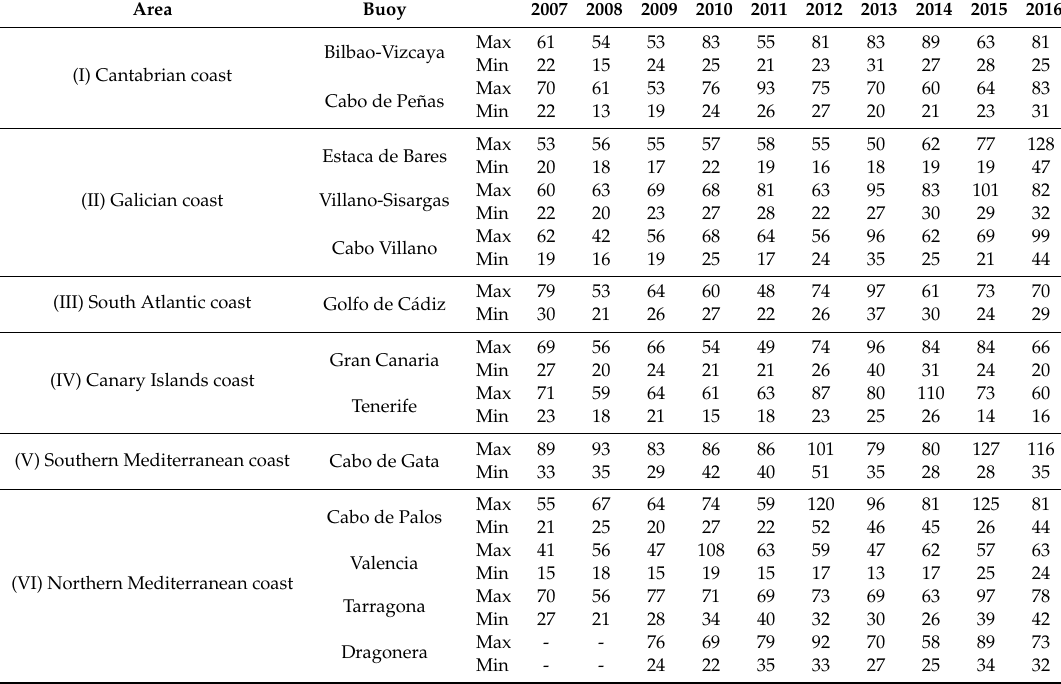
Table 4. Marine current speed, in cm / s, in all the areas in the Spanish coast between 2007 and 2016. Area